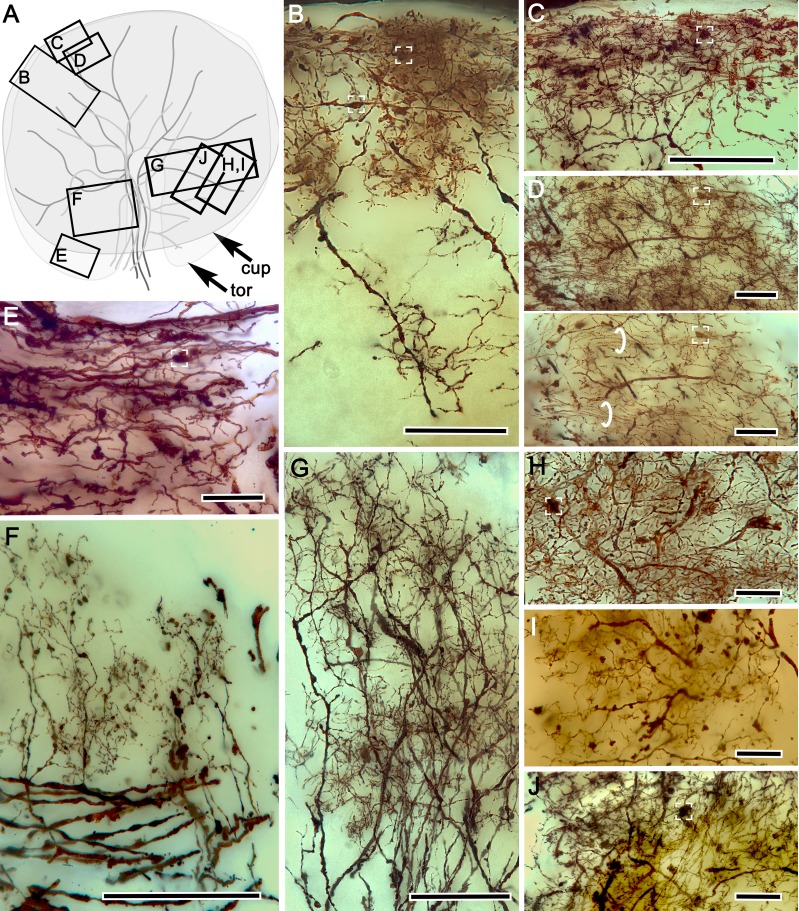
Neuronal arrangements in the hemiellipsoid derivative.(A) Schematic of crayfish hemiellipsoid body viewed from above, showing the outlines of the torus (tor) overlaid by the cupola (cup). Large branching elements correspond to TH- and 5HT-immunoreactive efferent neurons. Boxes B-J denote locations of neurons illustrated in panels (B-J). Neurons contributing to the cupola’s palisade of intrinsic neurons. Presynaptic boutons of terminals from the olfactory globular tract (OGT) indicated by white brackets (B–E). (C) Mass impregnation of presynaptic OGT endings in the outer layer of the cupola. (D) Two images, the upper showing a top-down view through 40 microns of the cupola outer layer, the lower showing an optical slice in which bundled parallel fibers (circled) can be more clearly isolated from other elements. (E) Terminal OGT boutons and parallel fibers at the margin of the torus. (F) Palisades of collateral dendrites originating from efferent neurons. (G) Bistratified palisades of intrinsic neurons in the torus. (H–J) Dorsal view of systems of local interneurons intersecting the inner intrinsic neuron layer. Scale bars for B, C, F and G = 50 μm; for C, D, E, H-J = 20 μm.